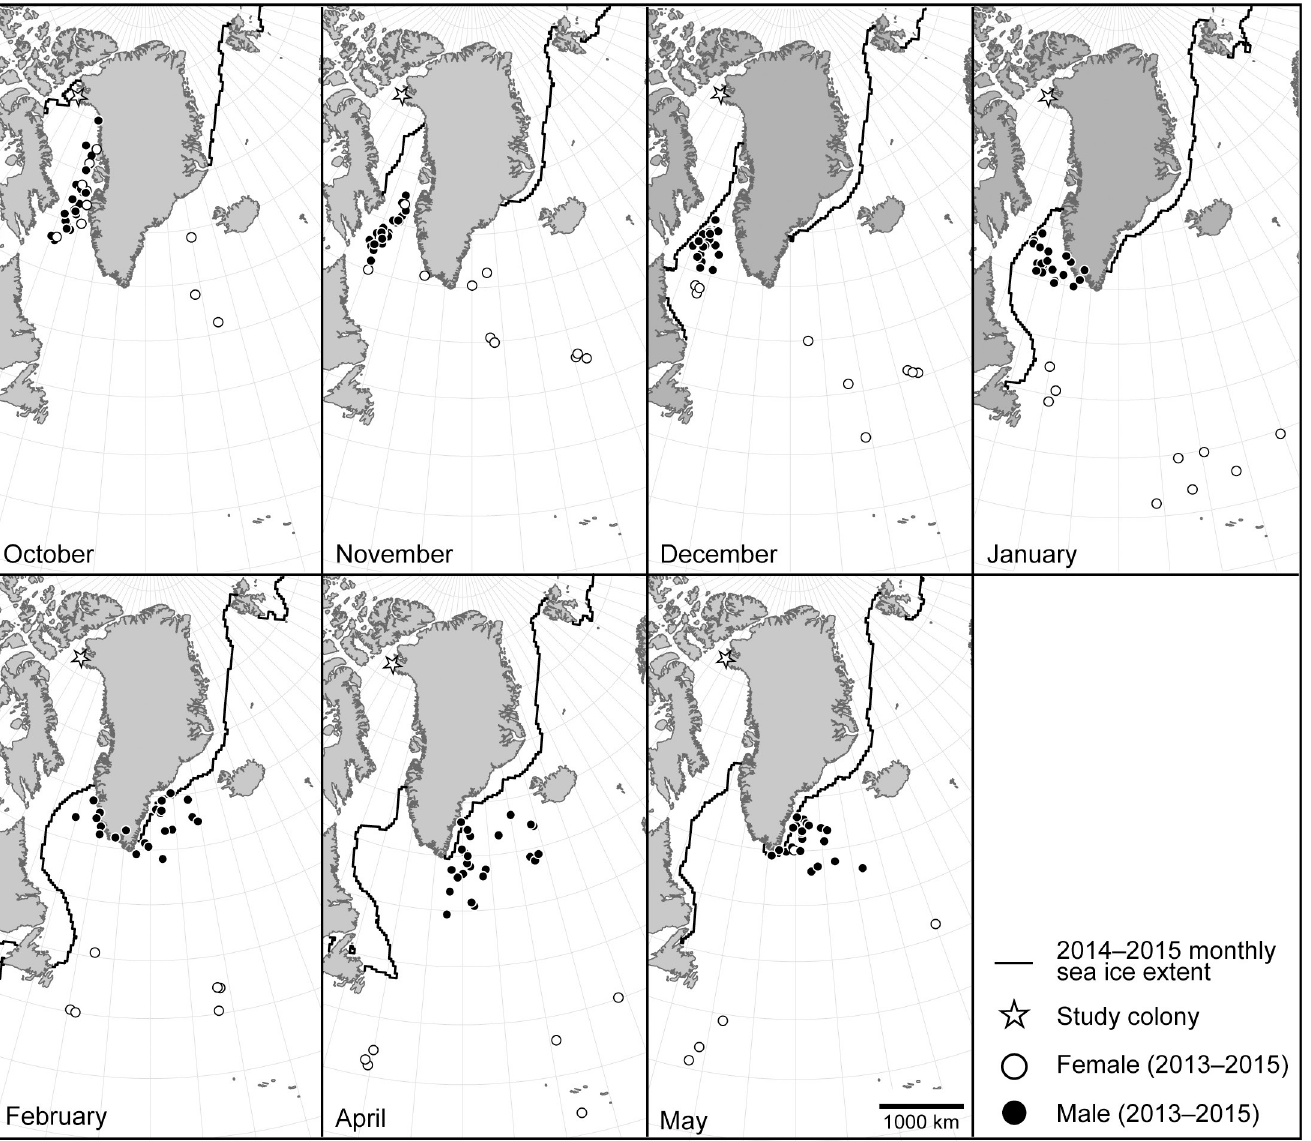
Fig 2. Tri-monthly median locations of nine adult Atlantic puffins from northwest Greenland. Monthly maps indicate segregation of puffins by sex during the non-breeding season with each individual bird represented by a maximum of three points per month. Locations on the Greenland Ice Sheet are a result of individuals rapidly transiting around the southern tip of Greenland from the southwest to southeast, thus resulting in a median location on the Greenland Ice Sheet. Data source for country boundaries is [28] and monthly sea ice extent data is from [55].